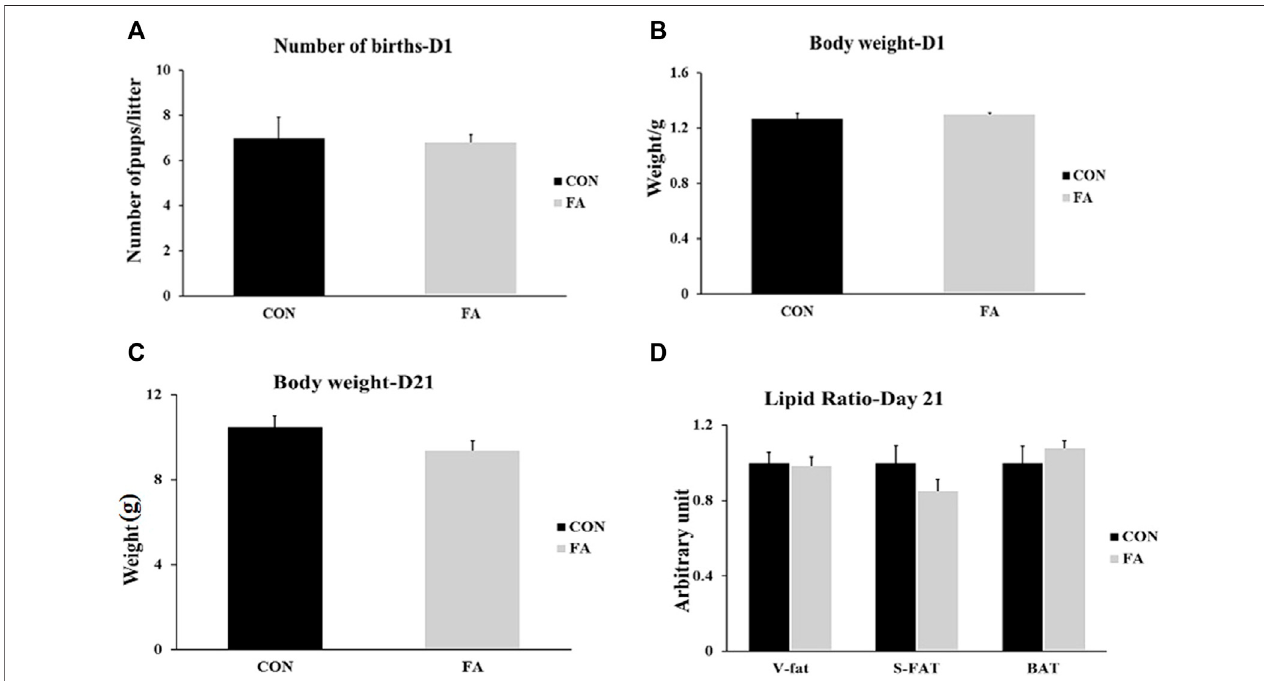
FIGURE1| EffectofmaternalintakeofEPA/DHAenricheddietonnumberofbirthsandbodyweightofnewbornpupsatD1andD21.Themotherswereassigned to two groups, one received control diet (CON) and the other was fed EPA/DHA enriched diet (FA). (A) Statistical analysis ofnumber ofbirths (B) Body weight difference between tested groups at D1. (C) Body weight difference between tested groups measured in gram at D21. (D) Fat ratio corrected by body weight. Body weight was measured in gram. Data was analyzed by Student ’ s t-test ( n = 20) and represent as mean ± SEM. Non-signi fi cant difference was observed between groups. Fat ratiowascalculatedbydividingtheweightofacertainfatdeposits(BAT,visceralfat,andsubcutaneousfat)ontotalbodyweightandtheresultswasnormalizedbybody weight.